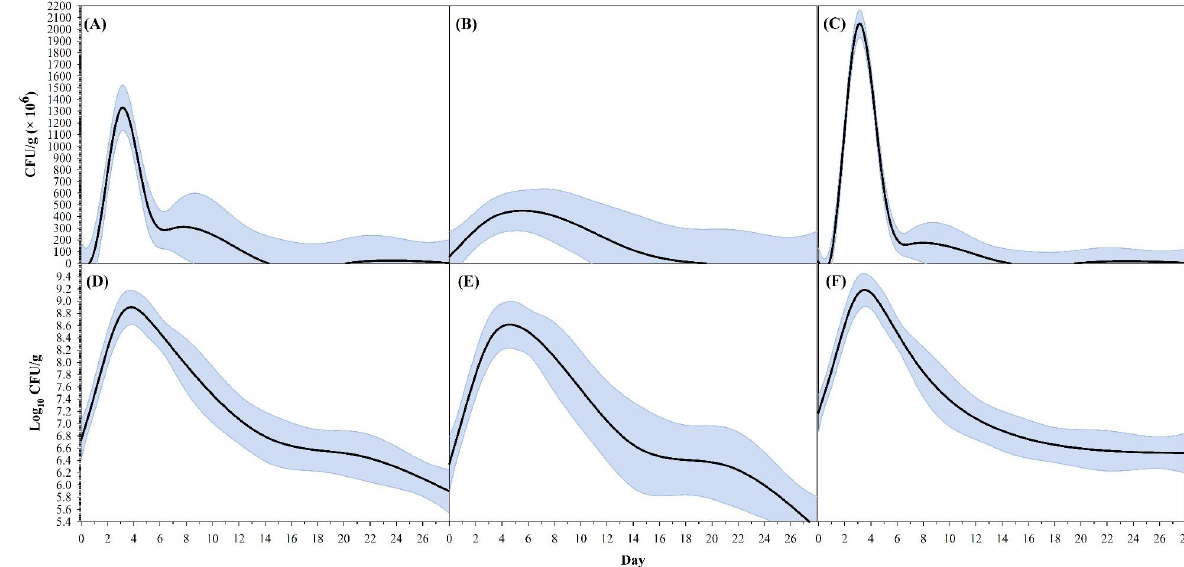
Figure 5. Comparison of virulent Aeromonas hydrophilia population (log 10 CFU g −1 ) in soil samples collected from 2 farms (2 ponds/farm × 3 replicate tanks per pond), Within each box plot, solid black horizontal line indicates the median, dashed red horizontal line indicates the mean. Box plots with different lowercase letters are significantly different at p < 0.05.